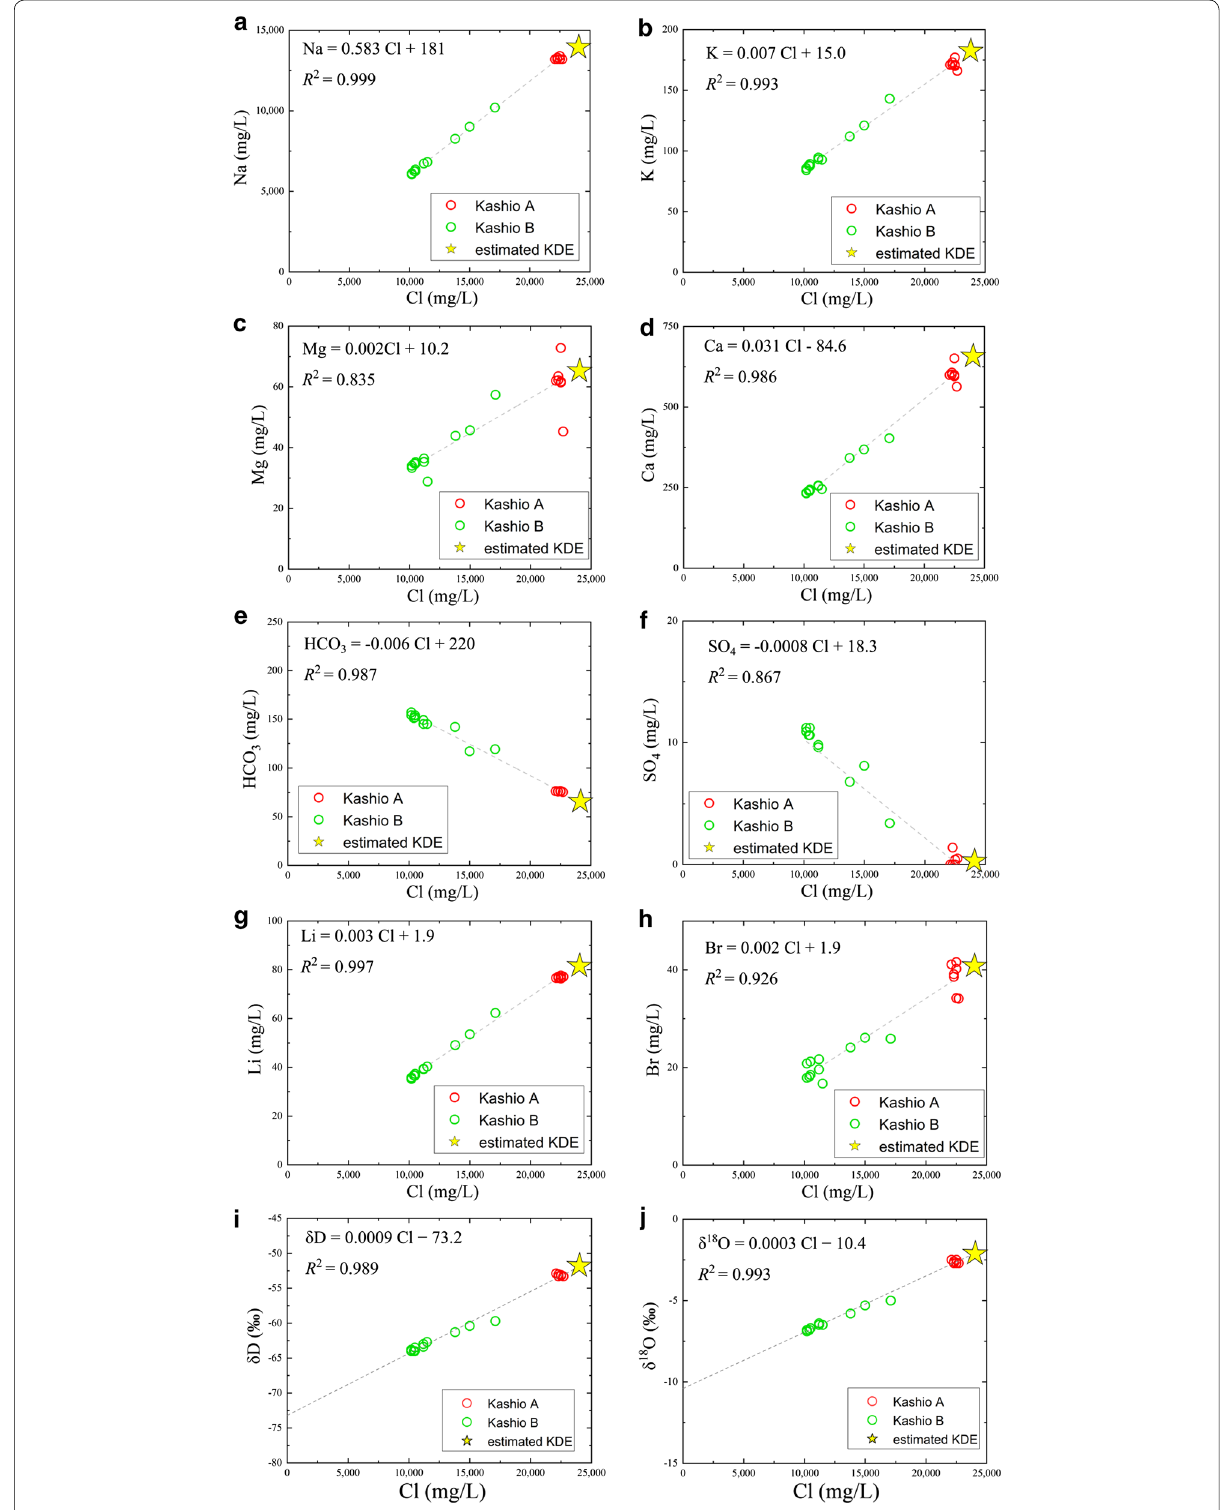
Fig. 8 Linear relationships between Cl and other atomic constituents. a Na, b K, c Mg, d Ca, e HCO 3 , f SO 4 , g Li, h Br, i δD, and j δ 18 O in water samples from the two Kashio wells. Also shown is the estimated chemical composition of KDE. ( R 2 correlation